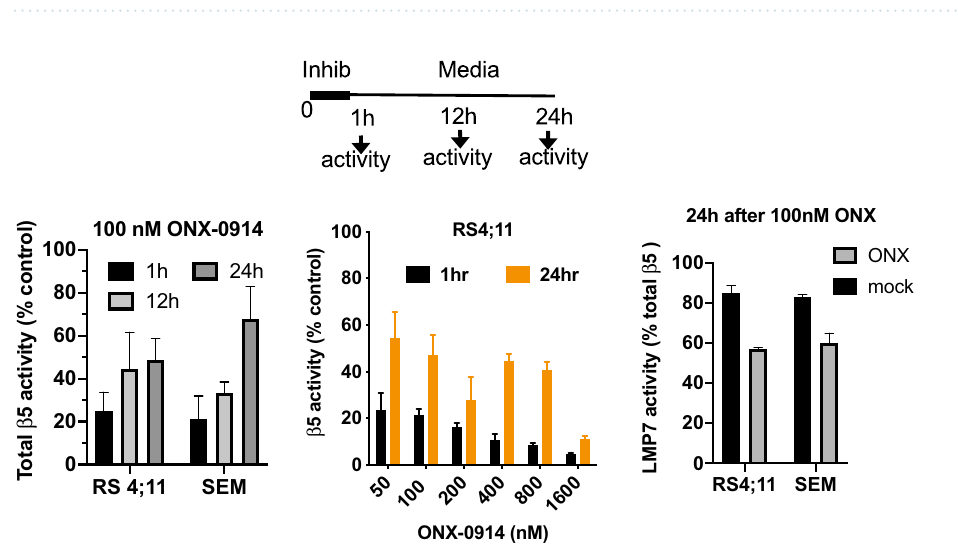
Figure 6. Immunoproteasome activity recovers after pulse treatment with sub-toxic doses of ONX-0914. The combined activity of LMP7 and ß5c sites was measured with Suc-LLVY-amc in extracts of ONX-0914-treated cells harvested immediately after 1 h treatment or after subsequent culturing in drug-free media (n = 3–7). On the right panel, extracts were treated with the highly specific immunoproteasome inhibitor LU-015i immediately before activity measurements (n =